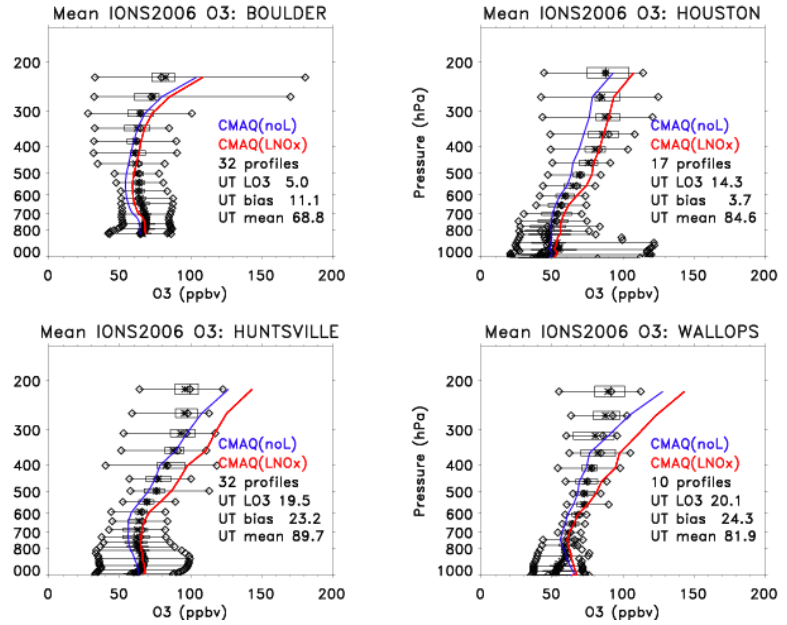
Figure 9. Mean vertical distribution of ozone at IONS sites during the summer of 2006. Results are shown for Boulder, CO (upper left), Houston, TX (upper right), Huntsville, AL (lower left), and Wallops Island, VA (lower right). CMAQ simulation noL (LNO x ) is shown in blue (red). For measurements, whiskers show minimum and maximum, while bars show the 25th and 75th percentiles. Median (mean) of measurements is shown with a diamond (asterisk). Numbers in the lower right hand corner show the number of profiles available, the lightning-NO contribution to upper tropospheric (7–12km) ozone (LO3), the upper tropospheric bias between modeled and measured ozone, and the mean measured upper tropospheric ozone from IONS.